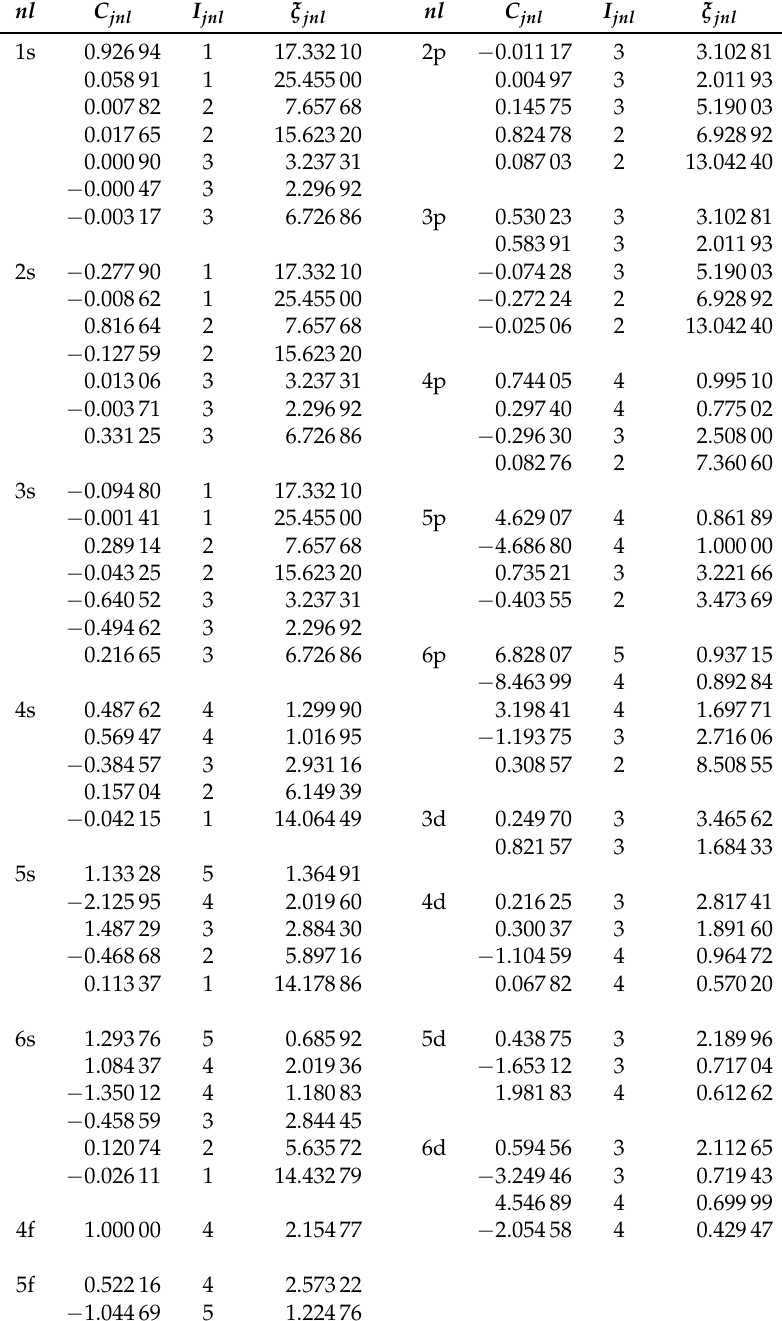
Table 2. Radial function